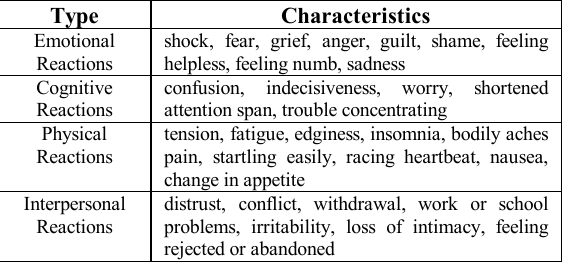
Table 1. Common reactions in the survivors after the event of disaster